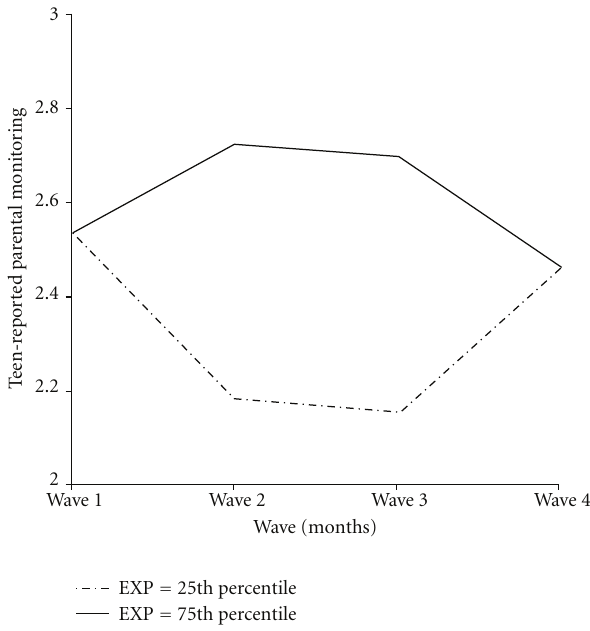
Figure 3: Teen-reported parental monitoring linear + quadratic slopes at di ff erent levels of EXP. EXP: parent attitudes about the impact of monitoring on adolescent risk behavior and experimen-